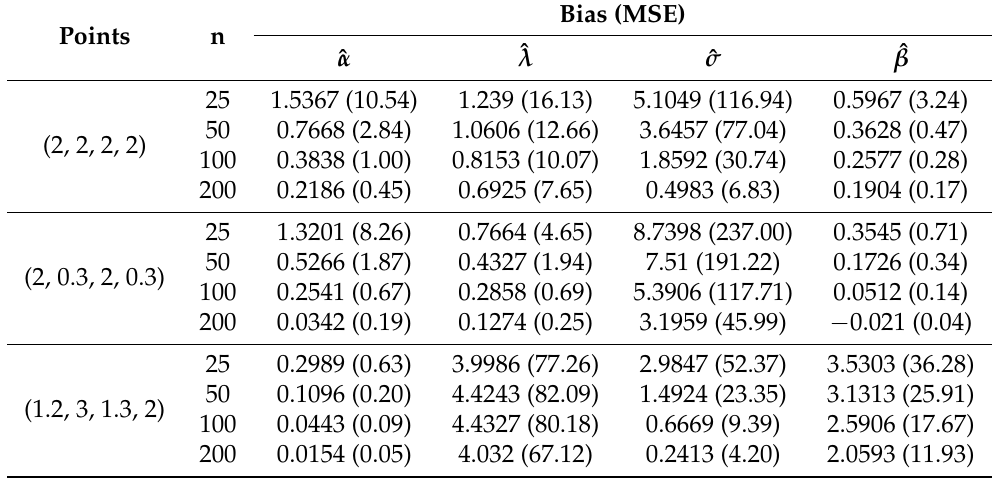
Table 2. Simulation study for quantifying bias and MSE of MLEs in several parametric points.